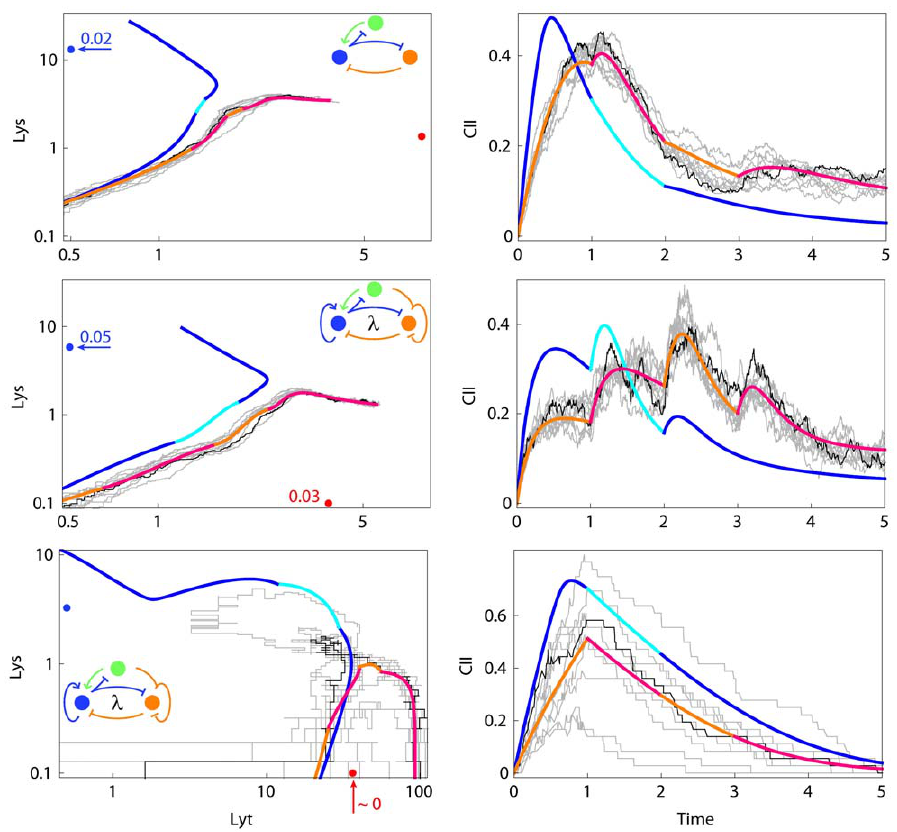
Figure 4. Examples of two-protein + CII networks that can perform the decision task in the presence of noise. In each network lyt and cII are co-transcribed. The upper two networks ( p.lyt.cII ) work at the standard 6% noise level, while in the lower network CII production is shut off after the first replication ( cII shut-off ). This network functions at a 20% noise level. The left panels are as in Figure 3. The right panels show the time development of CII. All times are shown in units of the phage genome replication time, whereas CII levels are shown in units of its binding constant for activation of Lys protein production.